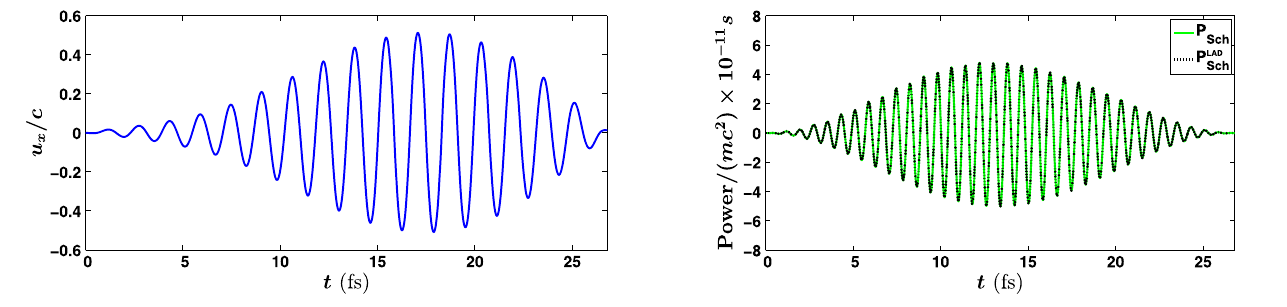
FIG. 6. Transverse velocity u x =c plotted vs time t for a sinusoidal-envelope linearly polarized laser pulse with parame- ters given in Fig. 4.